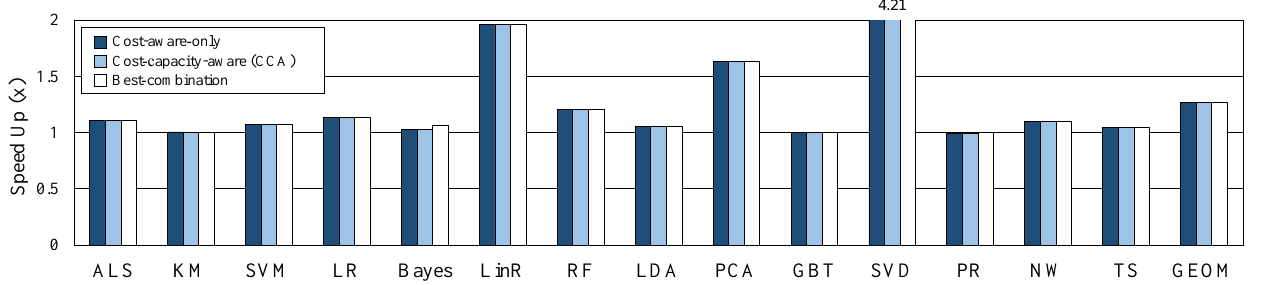
Figure 8. Comparison of three methods on sufficient cache memory.